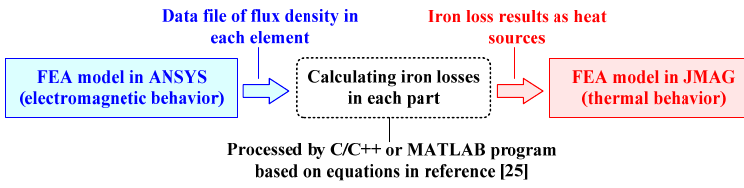
Figure 13. Flow chart of the analysis of electromagnetic and thermal behaviors, as well as relationship between different software.